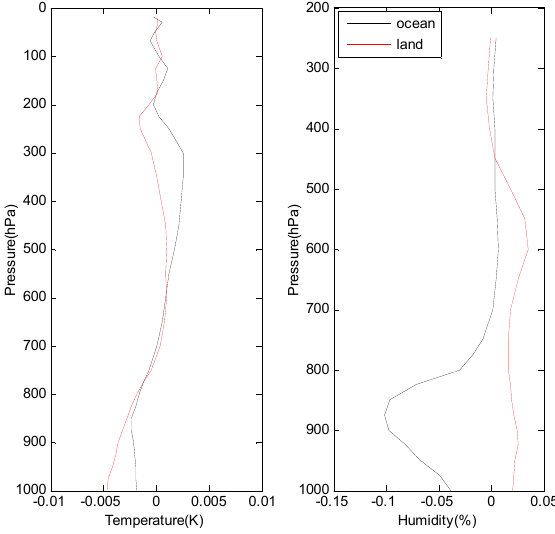
Figure 11. Same as Figure 10, but for retrieval accuracy.